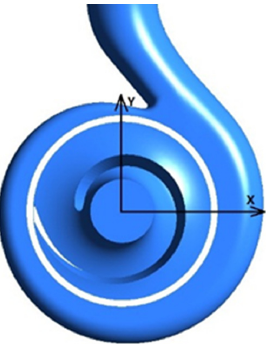
Figure 10. Coordinate diagram of force.